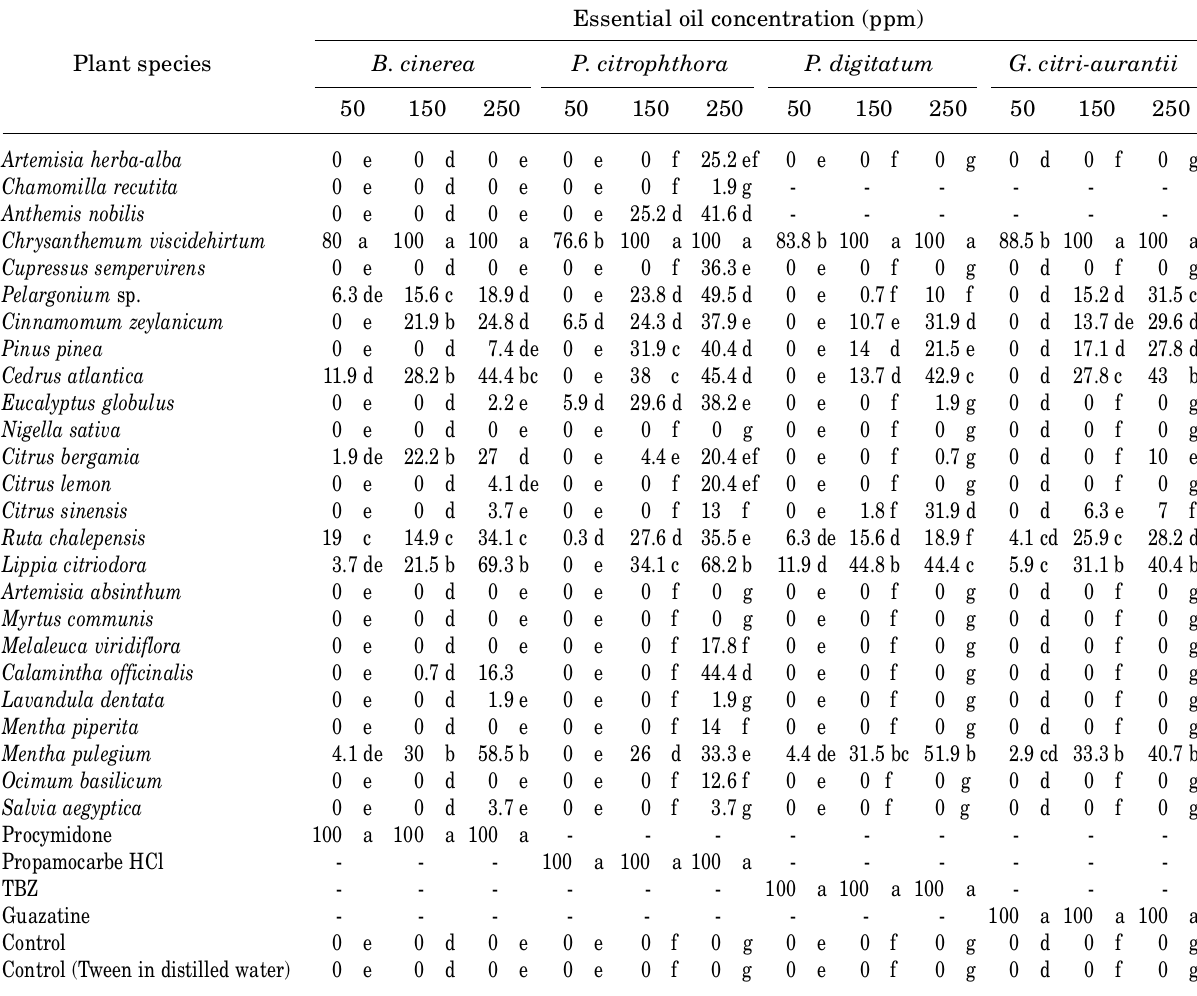
Table 2. Percent inhibition of radial growth of Botrytis cinerea, Penicillium digitatum and Geotrichum citri-aurantii on PDA, and of Phytophthora citrophthora on V8 medium when essential oils are added at different concentrations. Essential oil concentration